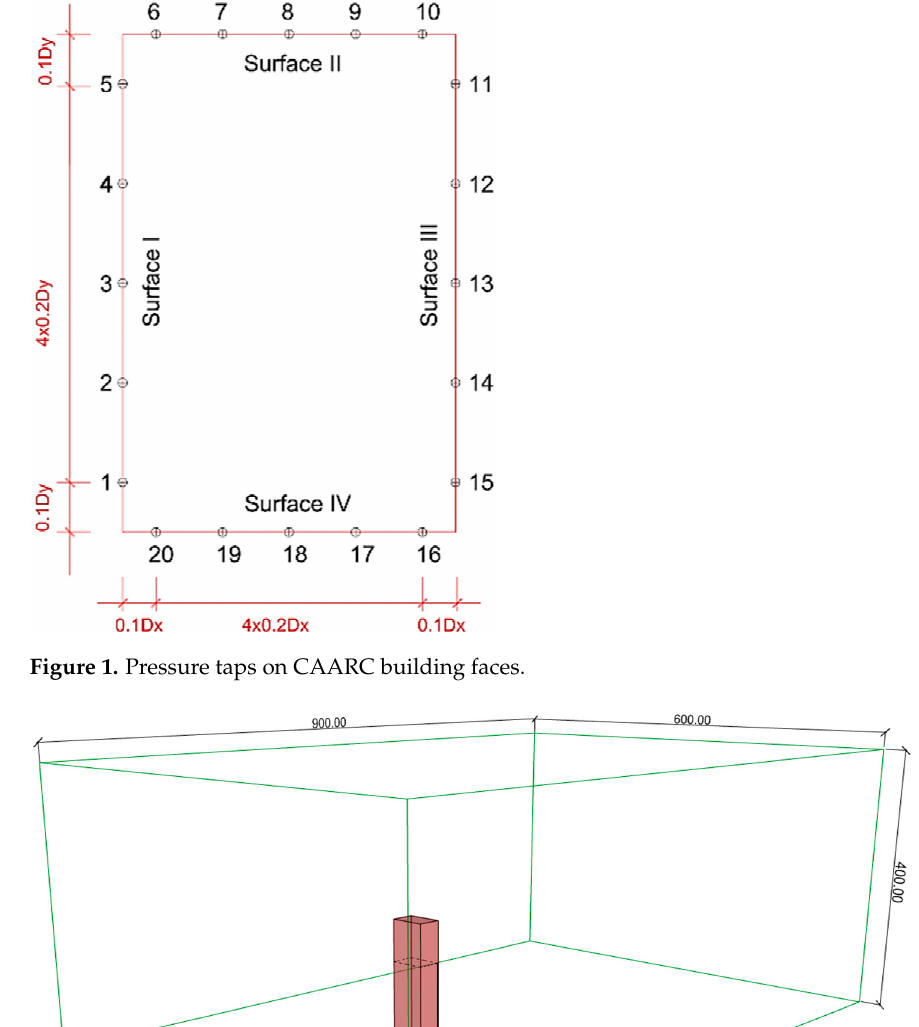
Figure 2. Wind tunnel